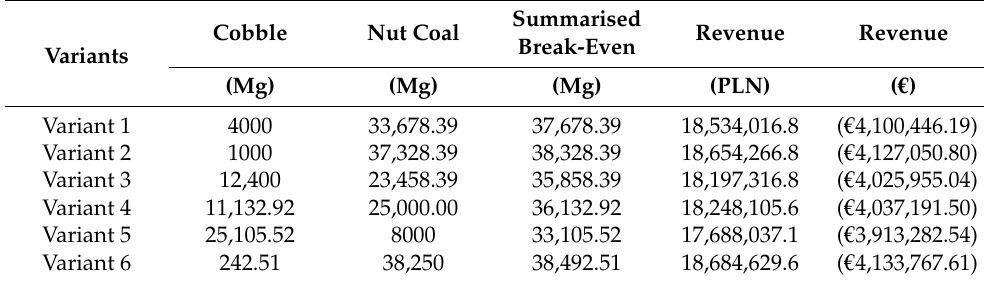
Table 2. Example threshold quantities for cobble and nut coal assortments, sum of threshold quanti- ties, and